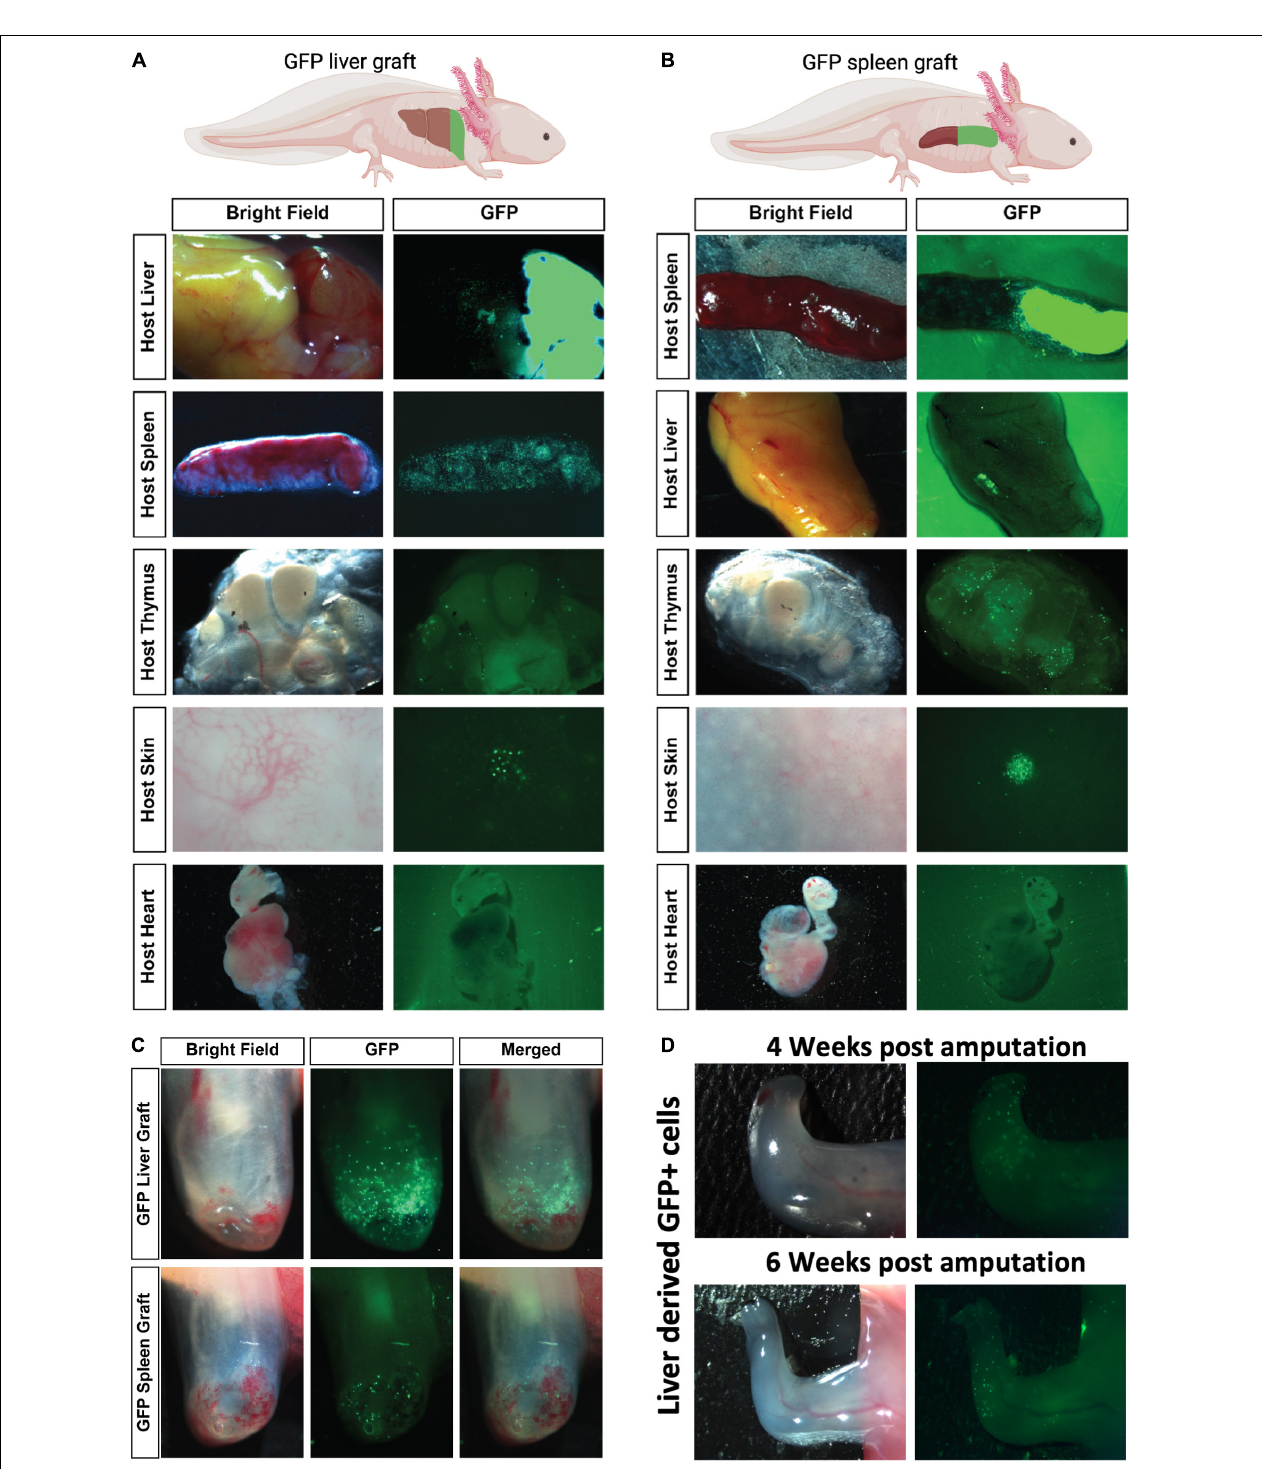
FIGURE 3 | Robust homing of liver-derived homing GFP + cells to amputated limbs and periphery following GFP + organ tissue grafts into leucistic hosts. (A,B) Representative ex vivo imaging of host tissues 7 days post organ tissue graft. GFP + liver grafted to host liver show that cells originating from this tissue have capacity to home in large numbers to the host liver, spleen but not the thymus, skin, or heart. GFP + spleen grafted to host spleen show that GFP + spleen cells can migrate in large numbers to the spleen and thymus and concentrated areas in the skin but show reduced migration to the liver and no migration to the heart. N = 4 host recipients. (C) Representative images of robust liver-derived GFP + cell recruitment. Limbs were amputated 1 week after organ tissue graft and imaged to detect GFP + cells migrating from graft to limbs 4 dpa. (D) Liver-derived GFP + cells still visible in regenerating limb 4 and 6 weeks post amputation ( N = 4).